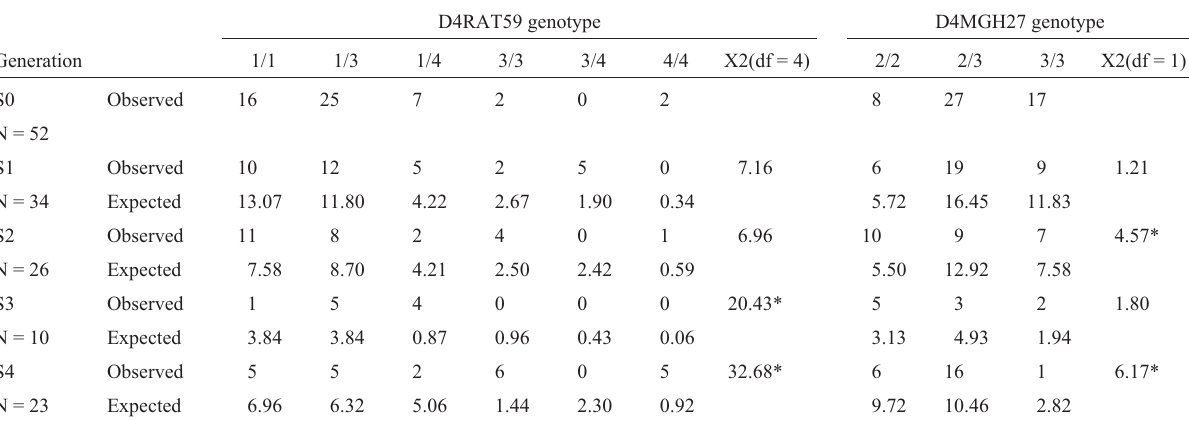
Table3 -Totalnumberofindividualspergenotypeclassandchi-squareforHardy-Weinbergequilibrium,foreachgenerationofFloripaLrats,inrelation to two markers for the QTL Ofil1 .